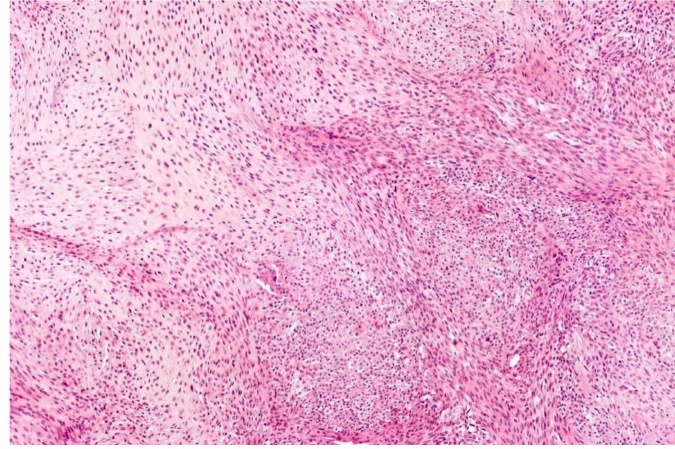
Figure 14. EWSR1-SMAD3 -positive fibroblastic tumor is composed of fascicles of bland looking spindle cells. There is an alternating cellularity with a hyaline matrix (HE; 20 × magnification). Immunohistochemically, the most reliable marker by now seems to be ERG demon- strating an homogeneous nuclear expression. Variable positive markers are SMA, keratins (both mostly week and focal), and SATB2. Reported negative stainings are EMA, desmin, S100, SOX10, CD34, CD31, MUC4, STAT6, TLE1, HMB45, and CD99. When a classical clinicopathologic constellation is present with expression of ERG, the diagnosis is straight forward. However fusion gene analysis may aid for the precise diagnosis, because benign and malignant lesions are in the differential diagnoses listed in Table 12 [167–171]. Table 12. Differential diagnoses of EWSR1-SMAD3 -positive fibroblastic